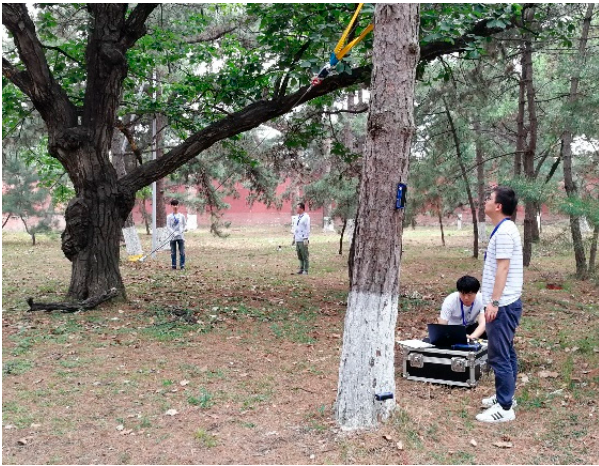
Figure 2. Field inspection of anchorage using the pulling test [45].